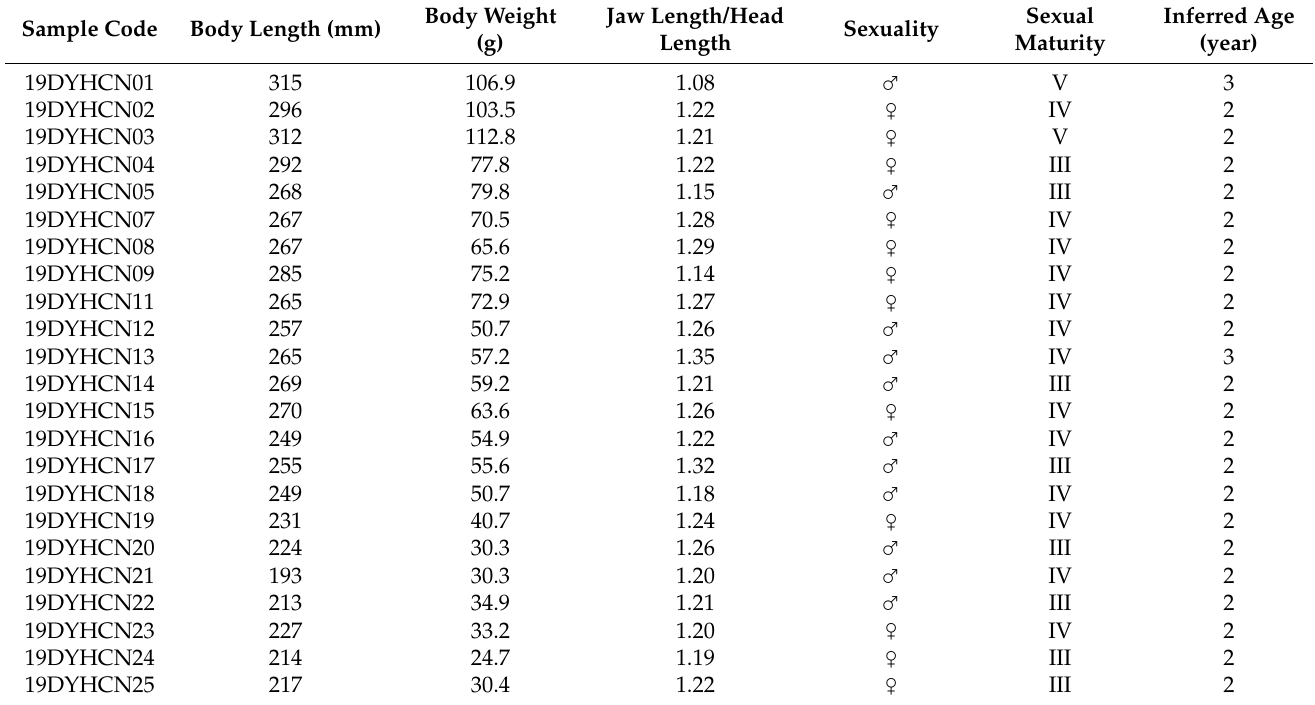
Table 1. Sampling details of Coilia nasus